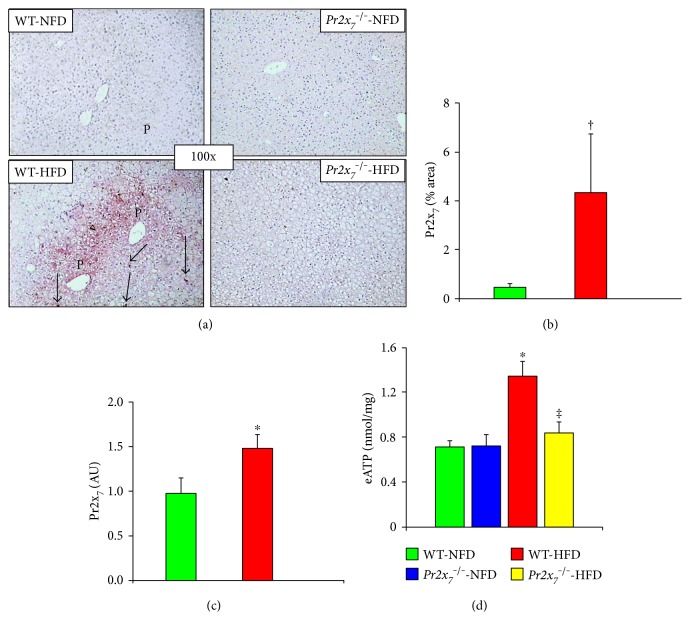
Hepatic PR2X7 expression. Immunohistochemistry for PR2X7 in liver sections from representative animals ((a); original magnification 100x) and quantification of liver PR2X7 protein content (b), Pr2x7 mRNA expression (c), and eATP levels (d) in NFD- and HFD-fed WT and P2x7r−/− mice (mean ± SD; n = 4–6 per group). P = portal space; > = parenchymal cell (hepatocyte) staining; → = nonparenchymal (sinusoidal lining) cell staining. ∗P < 0.001 or †P < 0.01 versus NFD-fed mice; ‡P < 0.001 versus WT mice. PR2X7 = purinergic receptor 2X7; Pr2x7 = PR2X7 gene; eATP = extracellular ATP; NFD = normal-fat diet; HFD = high-fat diet; WT = wild type.